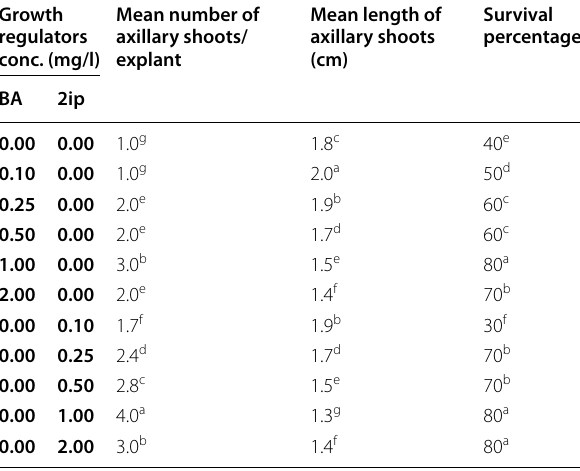
Table 2 Effect of BAP and 2ip on Dimocarpus longan growth and development